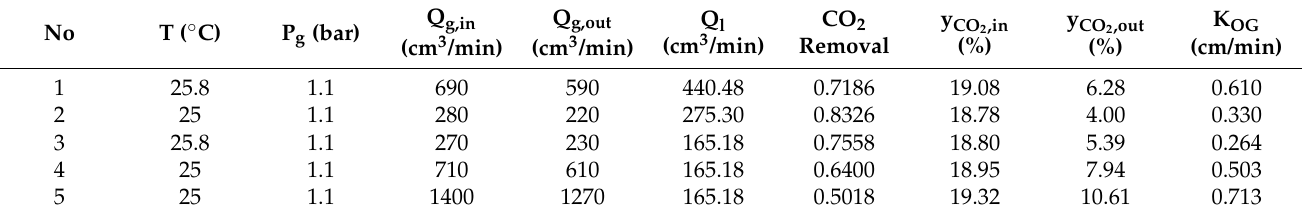
Table 5. Experimental operating conditions and calculated CO 2 removal efficiency and overall mass transfer coefficients.